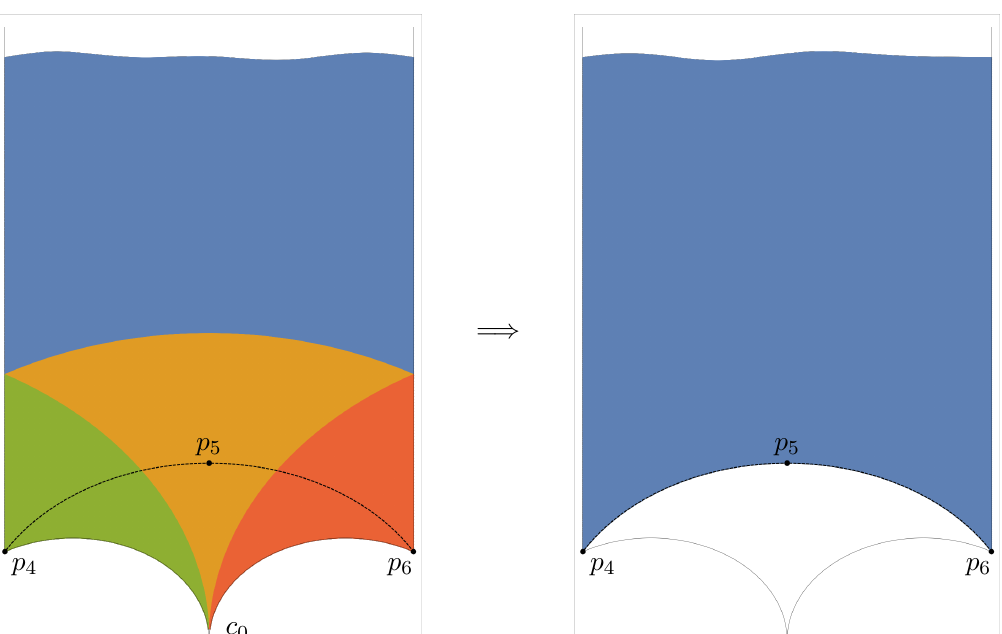
(3) /F . The marked points are 0 3 √ = − ¯ p . p = i/ 3 is the fixed 4 6 5